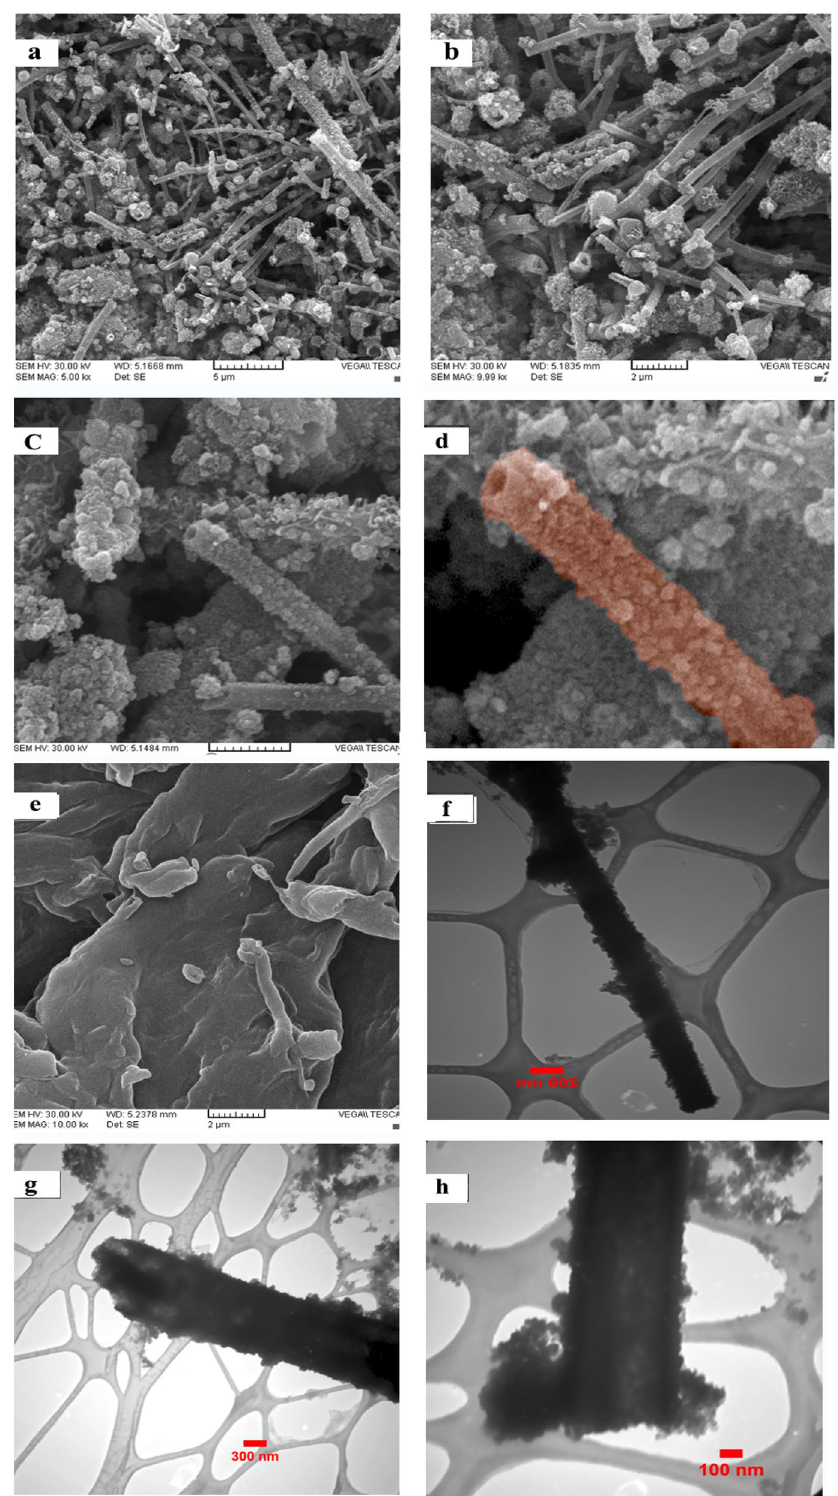
Figure 4. SEM images of ( a – d ) the agar supported ZnS/CuFe 2 O 4 , ( e ) agar, and ( f – h ) TEM images of the agar supported ZnS/CuFe 2 O 4